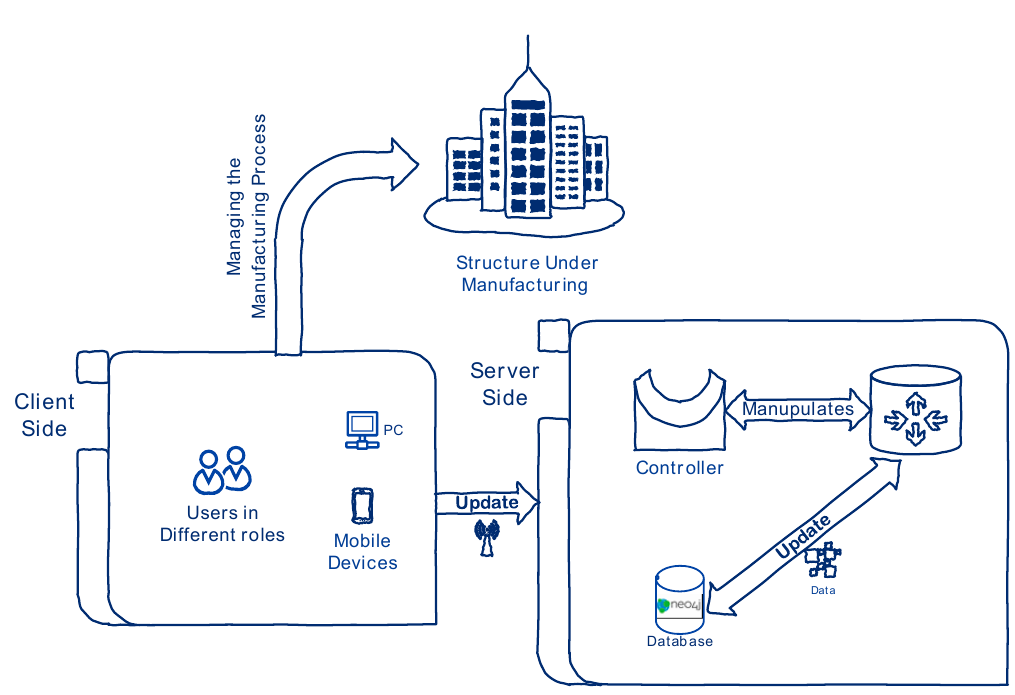
Figure 6. The architecture of the platform.